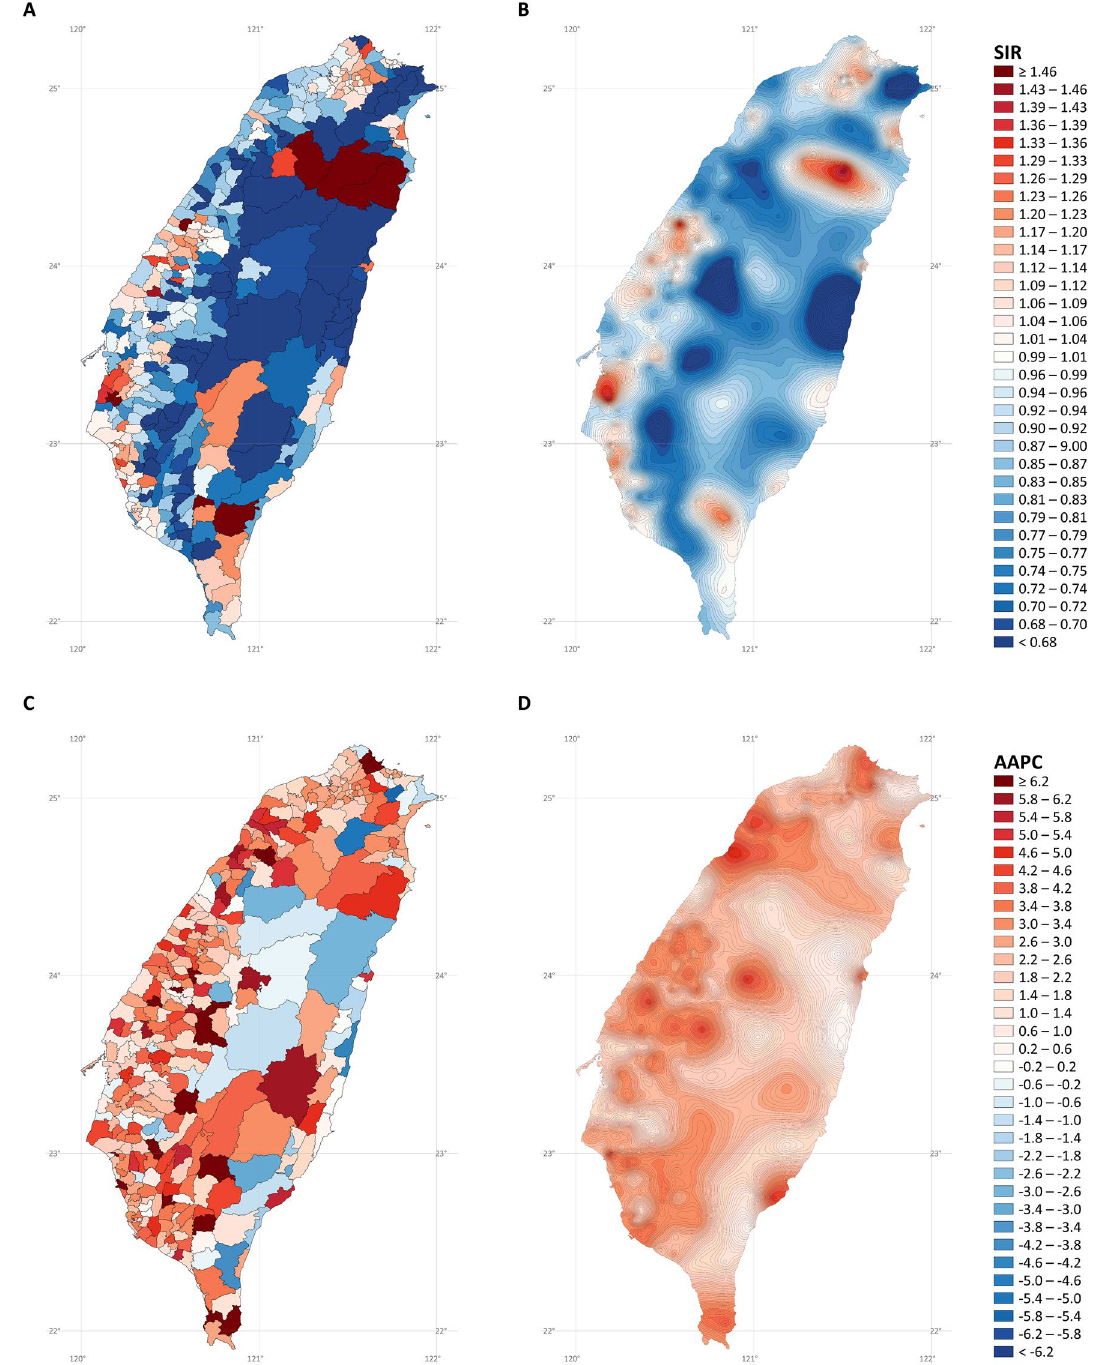
Figure 5. Maps of lung cancer in females ( A) standardized incidence ratios; ( B) stabilized kriged standardized incidence ratios; ( C) average annual percent changes; ( D) stabilized kriged average annual percent changes). The map was created by R version 3.5.2 with the ggplot2 package (https:// cran.r- proje ct. org/ web/ packa ges/ ggplo t2/ index. Smoking prevalence in women in Taiwan was low (< 6%), and it has further decreased in recent years 7 . The lung squamous cell carcinoma incidence rate in women decreased consistently from 1997 to 2017—similar to that in men (Fig. 1 and Supplement 8). The decreasing trend may also be related to a decrease in ETS exposure. ETS inhalation—secondhand or passive smoking—can lead to cancer and thus increase lung cancer incidence rates 19,20 . ETS exposure is primarily familial, and female nonsmokers exposed to ETS have a higher risk of lung squamous cell carcinoma than those without ETS exposure 21 . Nonsmoking women exposed to a smoking environment since childhood have a 70% higher risk of lung cancer than nonsmoking women who were not